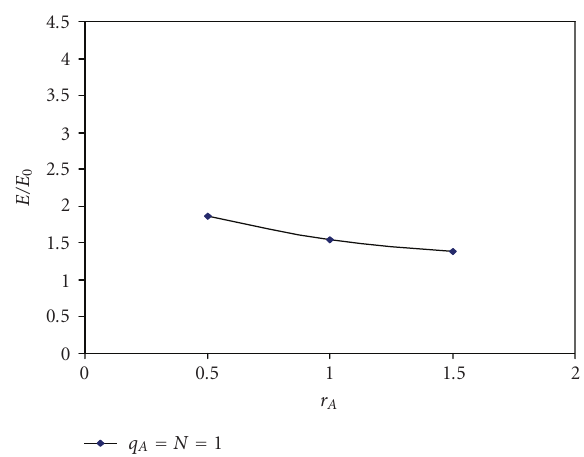
Figure 4: Enhancement factor as a function of r A for SO 2 – slurry system. Mg(OH) 2